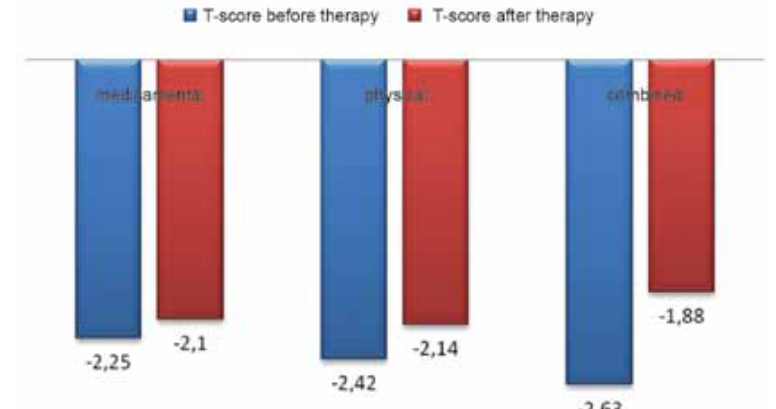
FIGURE 5. value of t-score before and after therapy